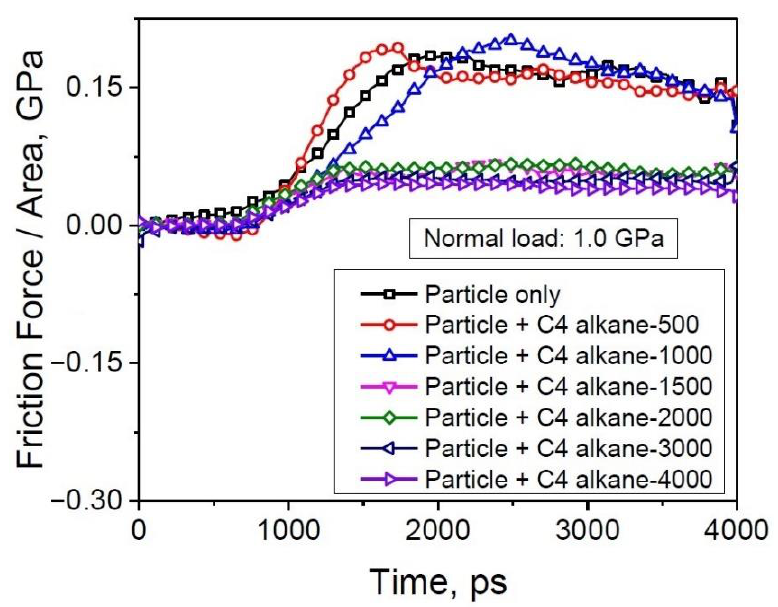
Figure 12. Comparison of the friction force evolution history against the simulation time between the particle and lubricated models under the normal load of 1.0 GPa. The number of C4-alkane molecules varies from 500 to 4000.